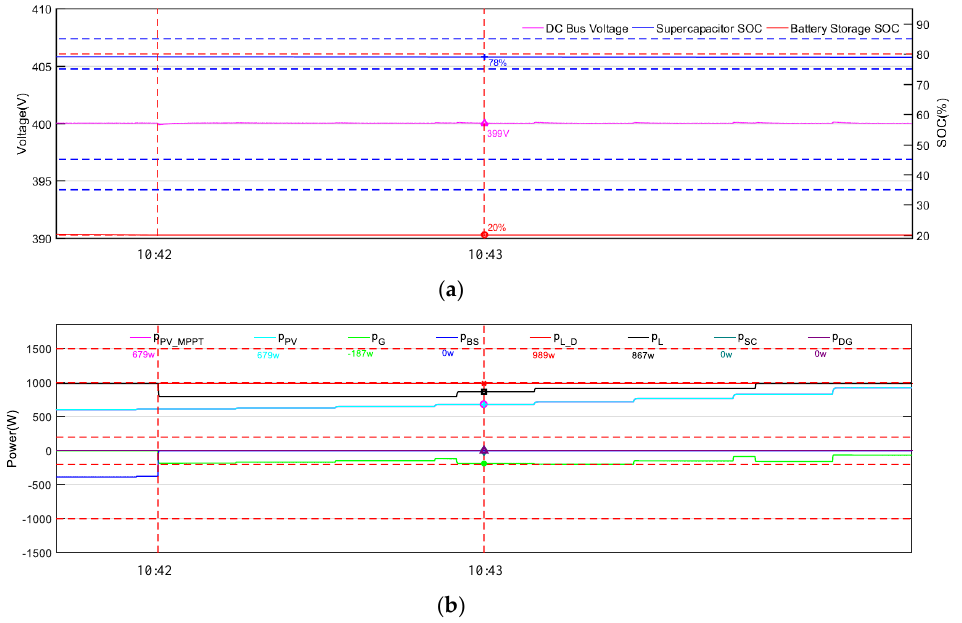
Figure 13. Curves of common DC bus voltage and SOC of storage ( a ) and curves of power ( b ) during load shedding.